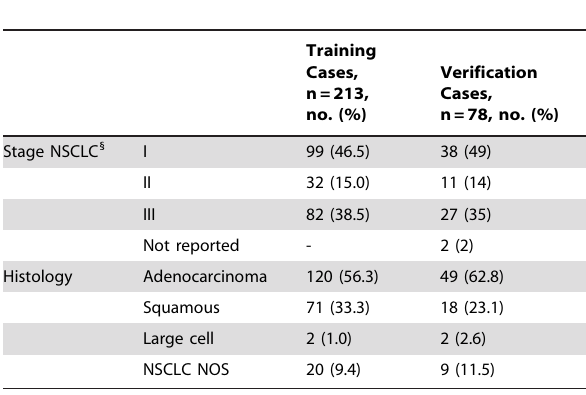
Table 3. Clinical characteristics of NSCLC cases in the training and verification